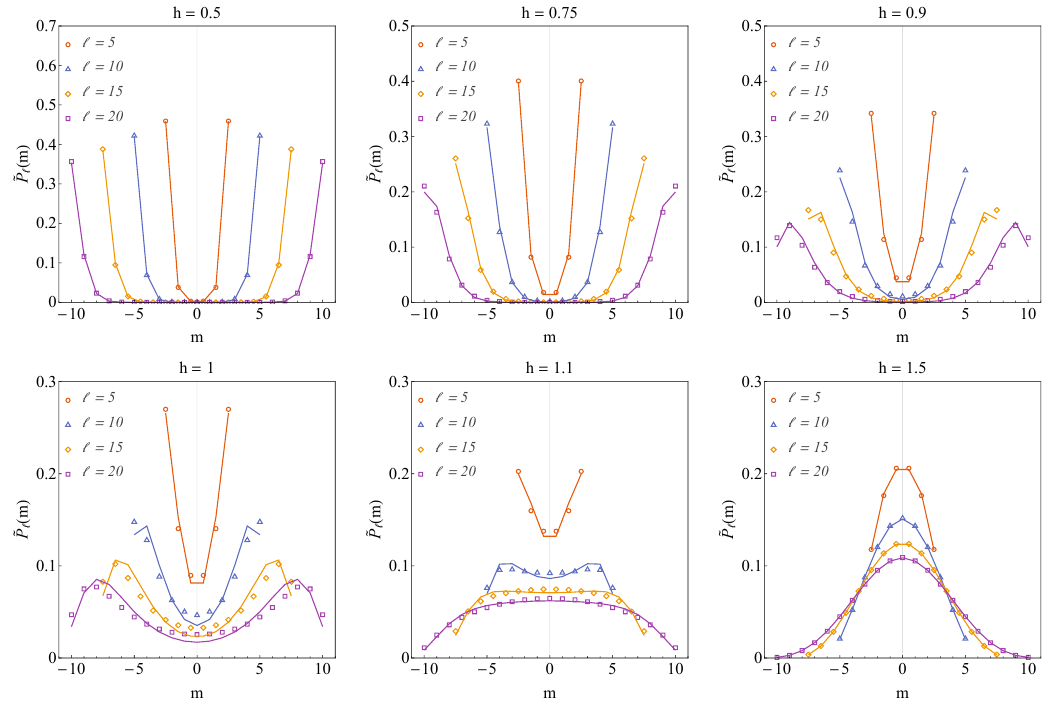
Figure 6: Exact ground-state PDF (symbols) is compared with the block diagonal approximation obtained by using Eq. (68) (full lines) for relatively small subsystem sizes and different values of the transverse